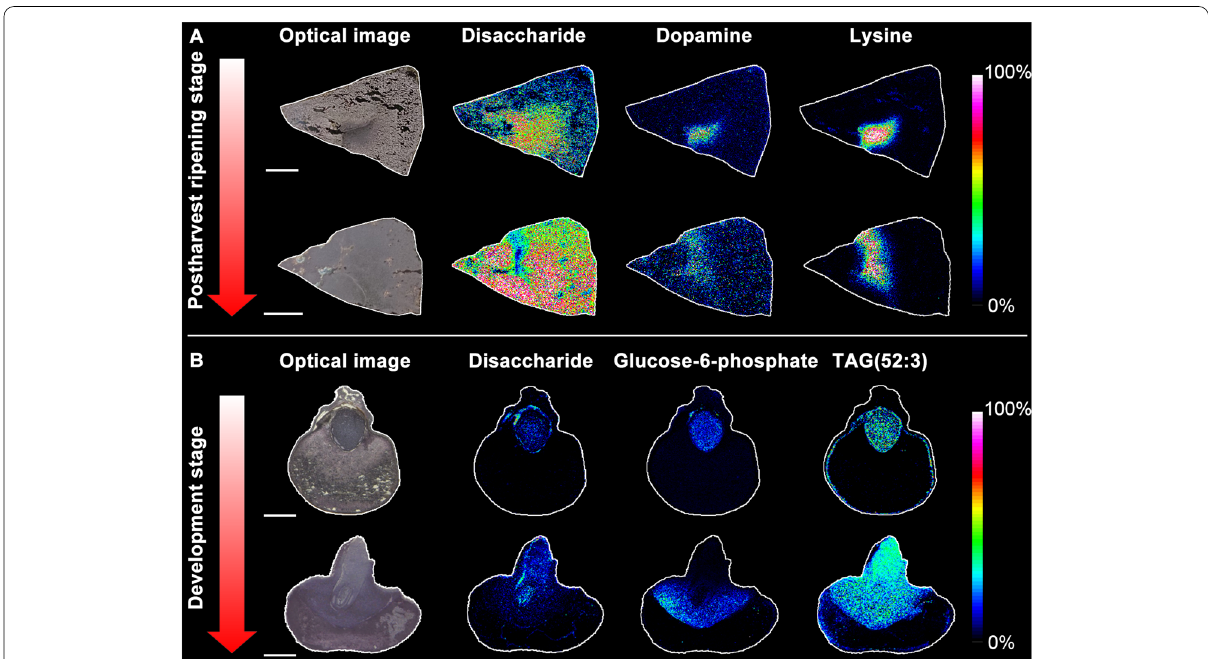
Fig. 5 Matrix-assisted laser desorption/ionization mass spectrometry imaging (MALDI-MSI) as a molecular exploratory tool in plant science. A The dynamic spatial distribution of disaccharides, dopamine, and lysine within banana pulps at different postharvest ripening stage. Scale bar, 5 mm. B The dynamic spatial distribution of disaccharides, glucose-6-phosphate, and TAG (52:3) within maize kernels at different development stages. Scale bars, 2.5